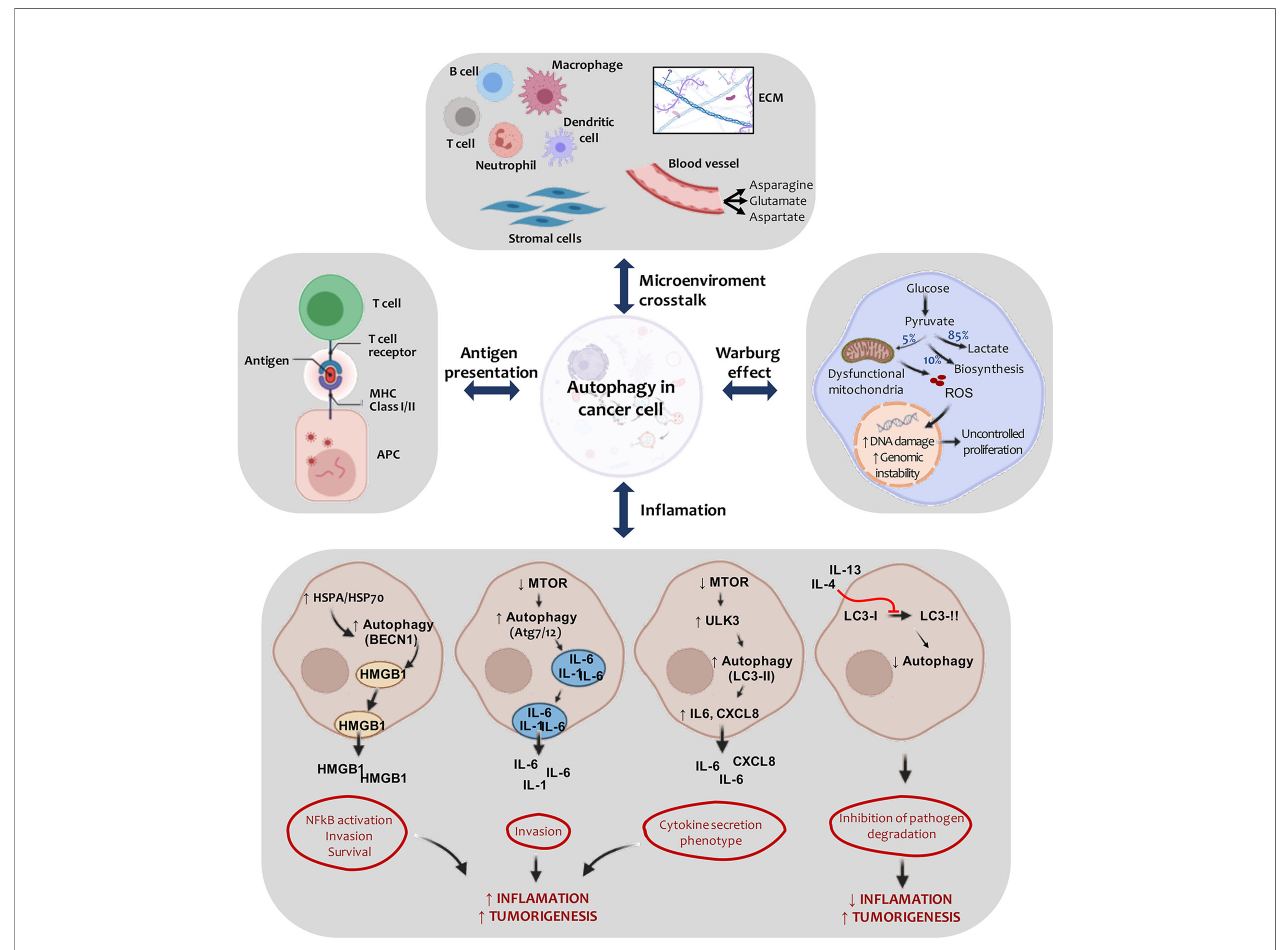
FIGURE 3 | Active crosstalk between autophagy and tumor microenvironment. Carcinogenesis is regulated by autophagy in transformed cells and cells belonging to the tumor microenvironment. Signaling is triggered to the ECM (extracellular matrix) and to stromal cells (such as fi broblasts and pericytes), generating a favorable context for tumor development. As tumor development progresses, cell autophagy activation in the tumor microenvironment serves, in part, to compensate for the inadequate nutritional supply associated with rapidly growing tumors. Here, proper quality control of the mitochondria is necessary to aid glycolysis in tumor cells. In this way, the energy balance (Warburg effect) typically found in malignant cells is maintained. Also, the autophagic process is involved in multiple aspects of lymphocyte development, innate immune signaling and antigen presentation by APCs (antigen presenting cells), processes that are relevant to the disease pathogenesis. HSPA/HSP70 overexpression can induce HMGB1 release in a BECN1-dependent process. This event culminates in the activation of NF k B and promotes tumor proliferation and invasion. Similarly, autophagy induction can contribute to IL-6, IL-1, and IL-8 secretion and promote in fl ammation. The expression of speci fi c cytokines may inhibit this process, generating a decrease in the in fl ammatory